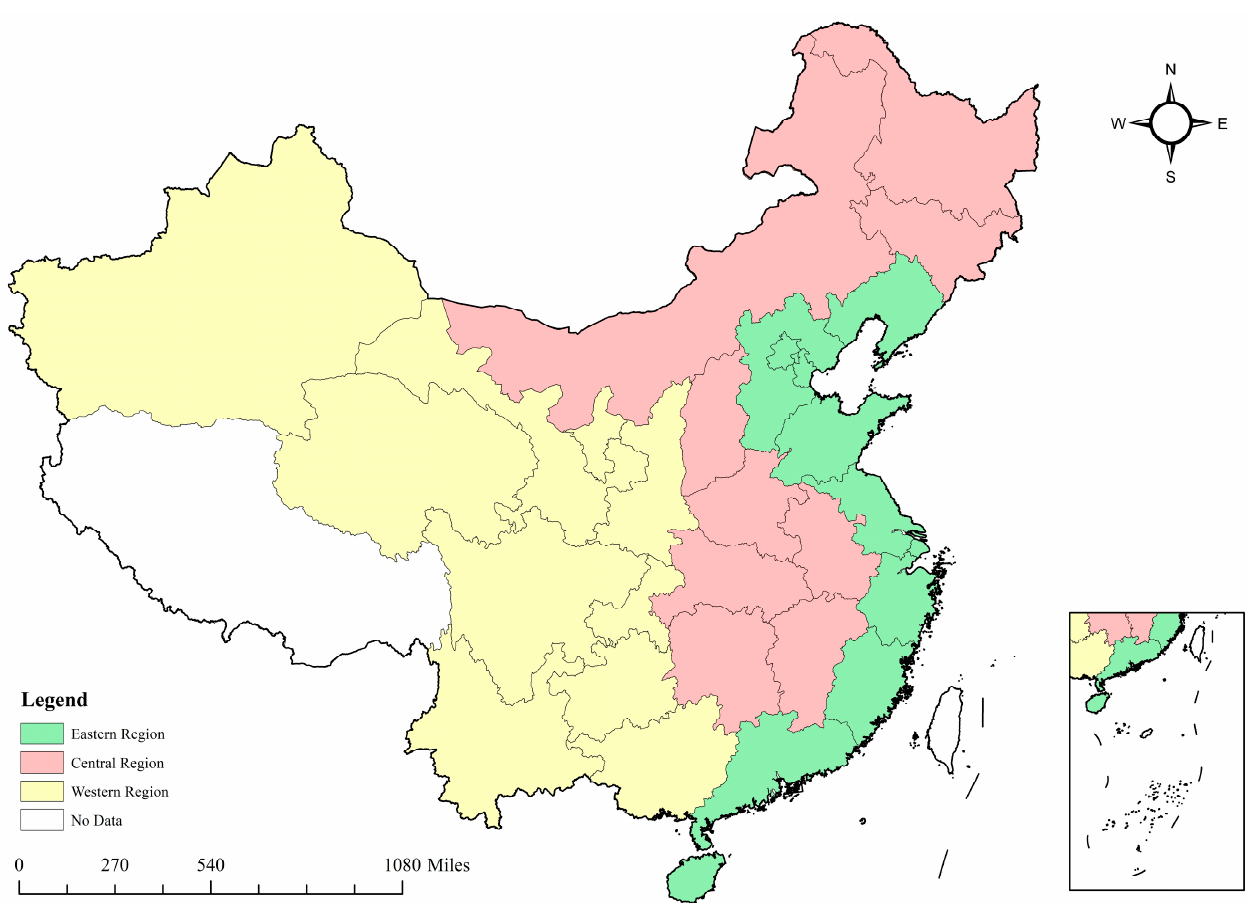
Figure 2. Study Figure 2. Study area.